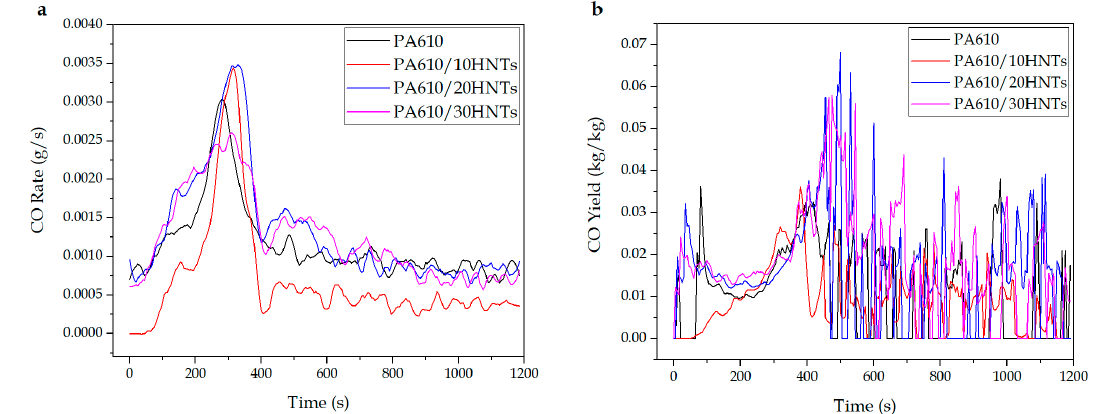
Figure 4. CO production during the CCT test: ( a ) CO rate and ( b ) CO yield.